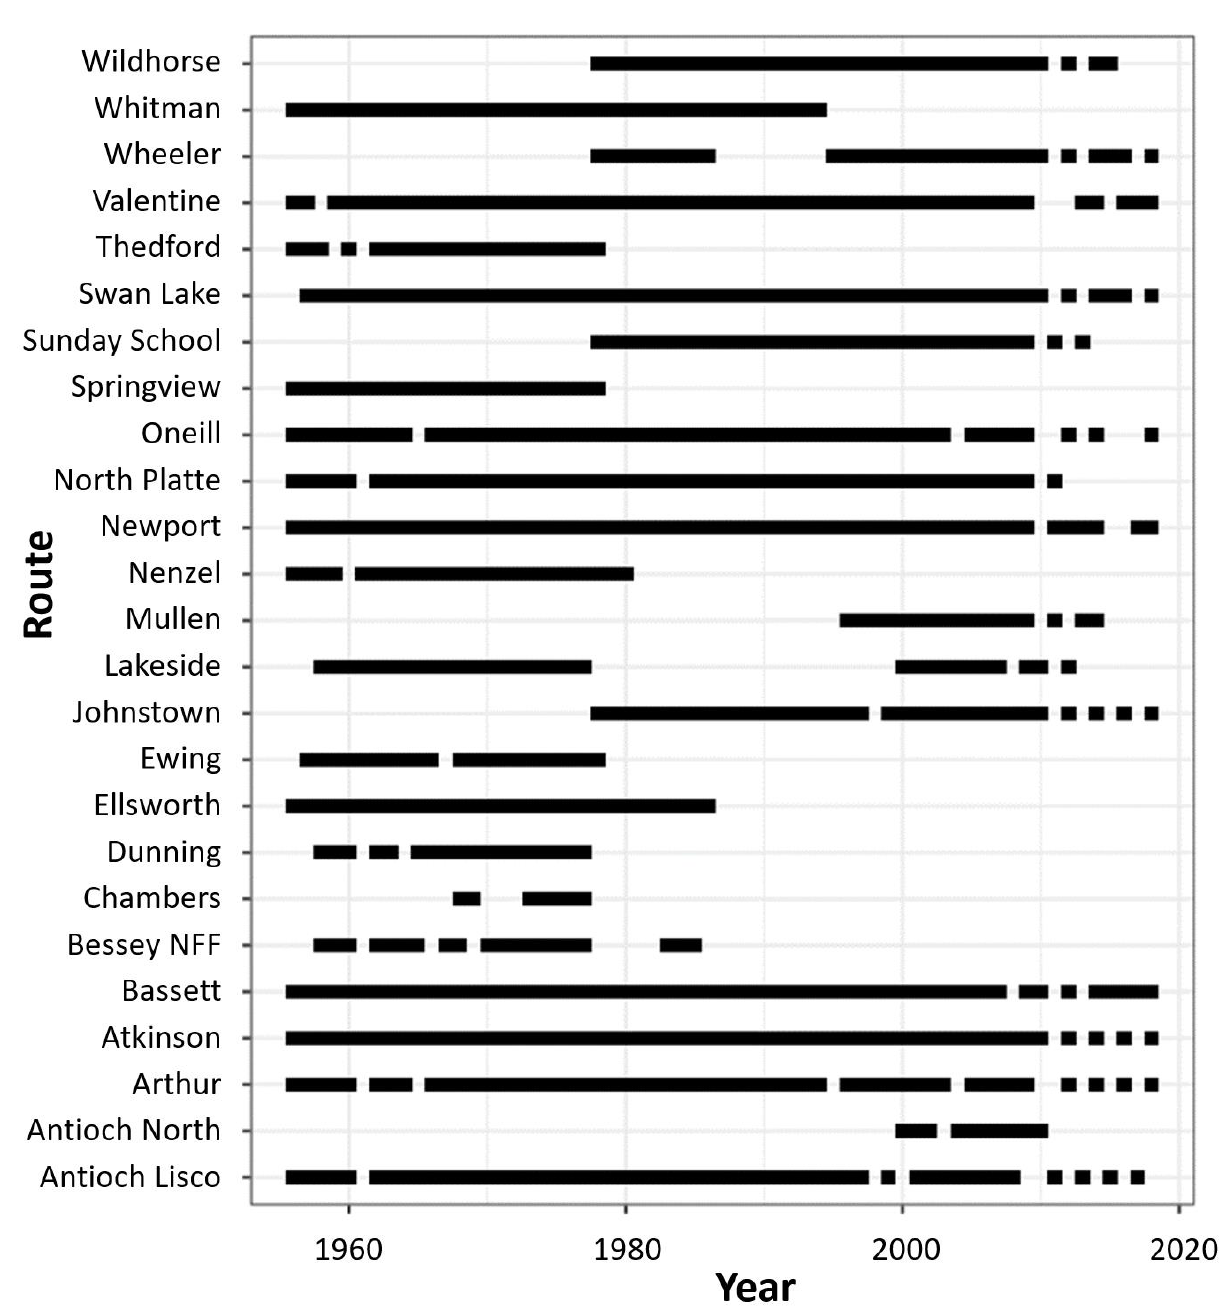
Figure 2. Available years of spring breeding ground count data from 1956 to 2018 for each of the 25 historical transects located in the Sandhills of Nebraska, USA. The black rectangles represent the collection of count data for a route in a given year. White spaces indicate an absence of data.